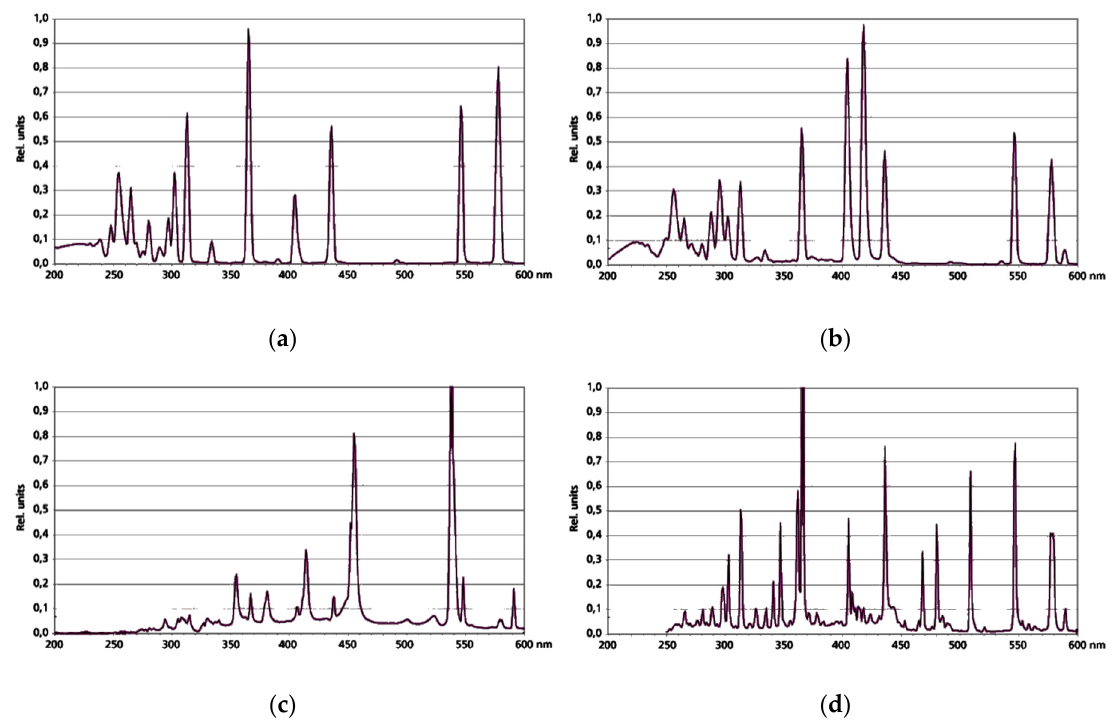
Figure 1. Characteristic of radiation wavelengths emitted by the tested UV lamps: ( a ) TQ, ( b ) TQ-Z1, ( c ) TQ-Z2, ( d ) TQ-Z3. (Materials were from the supplier of Heraeus UV lamp reactors KENDROLAB Sp. z